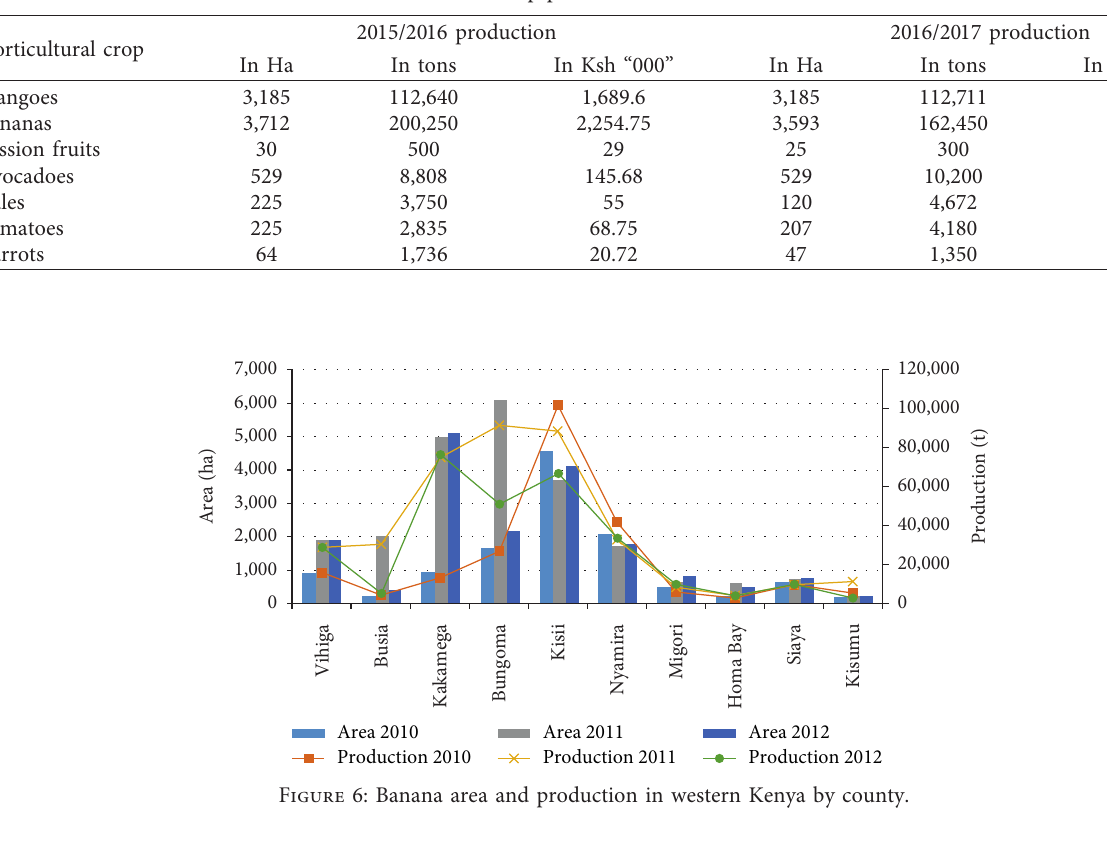
Table 3: Embu crop production trend in 2015–2017.